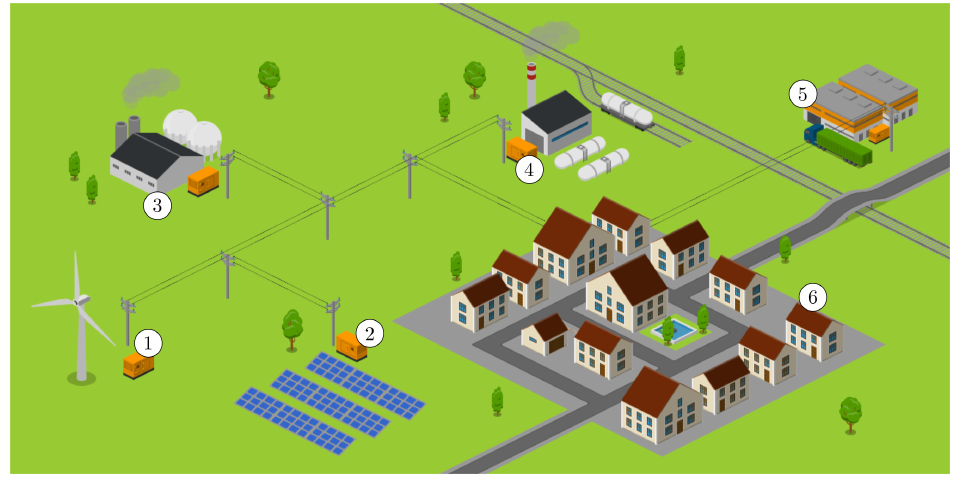
Figure 1. A MG (microgrid) considered in the problem, consisting of ( 1 ) a wind turbine, ( 2 ) photo-voltaic panels, ( 3 ) a microturbine, ( 4 ) a diesel engine, ( 5 ) an ESS (energy storage system), and ( 6 ) the